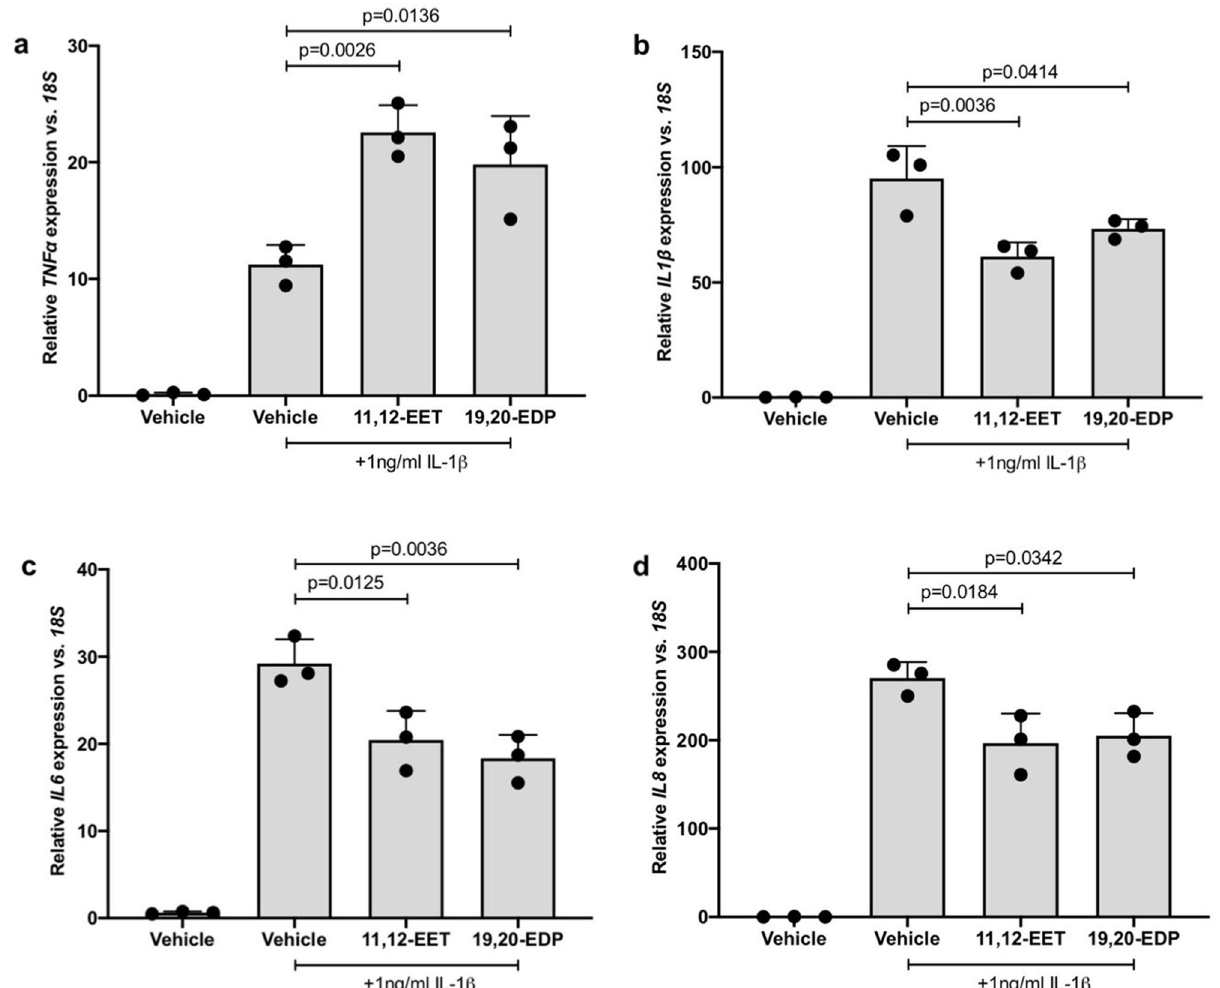
Figure 4. The effect of 11,12-EET and 19,20-EDP on IL-1β-induced inflammatory cytokine expression by Müller cells. Human Müller cells were treated with IL-1β (1.0 ng/ml) or IL-1β plus 11,12-EET (0.5 μM) or 19,20- EDP (0.5 μM) for 8 h. Total RNA was isolated and cytokine expression was assayed by qRT-PCR. ( a ) TNFα expression was significantly elevated while ( b ) IL1β , ( c ) IL6 , and ( d ) IL8 expression was significantly decreased by the addition of both exogenous epoxygenated fatty acids. Results depicted are representative of three separate experiments. These data are normalized to induction levels illustrated in Fig. 5. Data are displayed as mean ± SD (n =